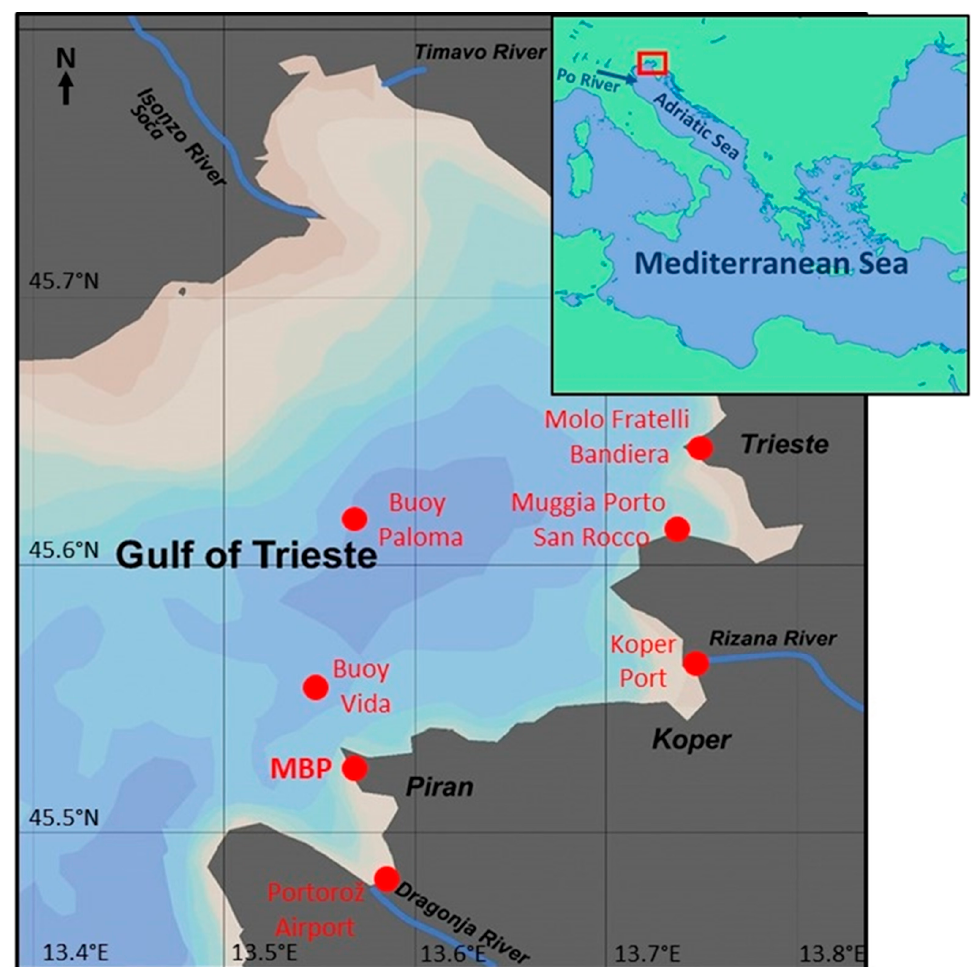
Figure 1. Gulf of Trieste with sampling and measurement locations.